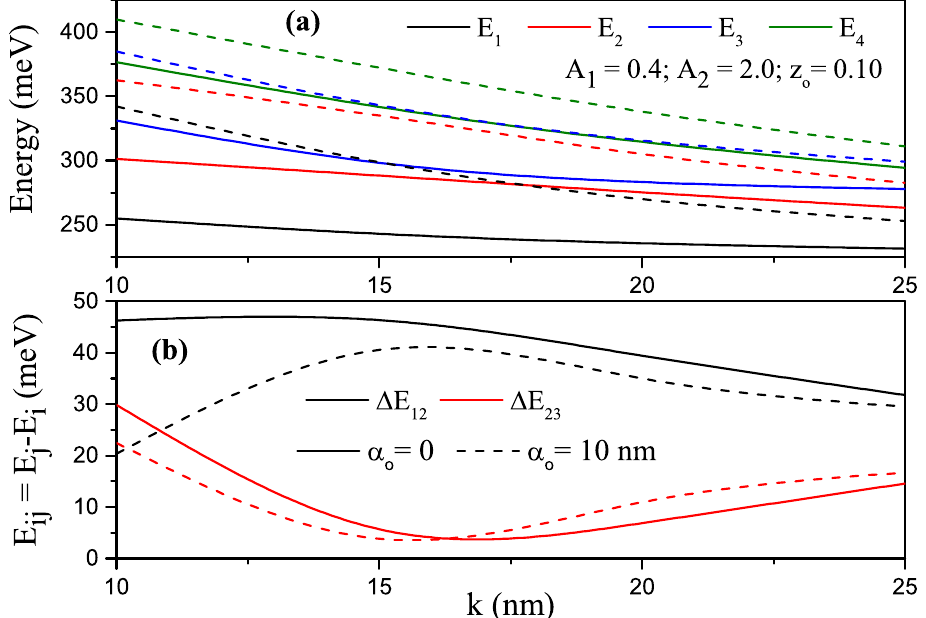
Figure 8. For A 1 = 0.4 and A 2 = 2.0 and z o = 0.10, ( a ) changes of the first four lowest energy levels of electron confined within parabolic–Gaussian asymmetric DQW under the intense laser field versus the k -parameter; ( b ) variation in energy differences between some levels versus the k parameter. Solid and dashed curves are for α o = 0 and α o = 10nm, respectively.